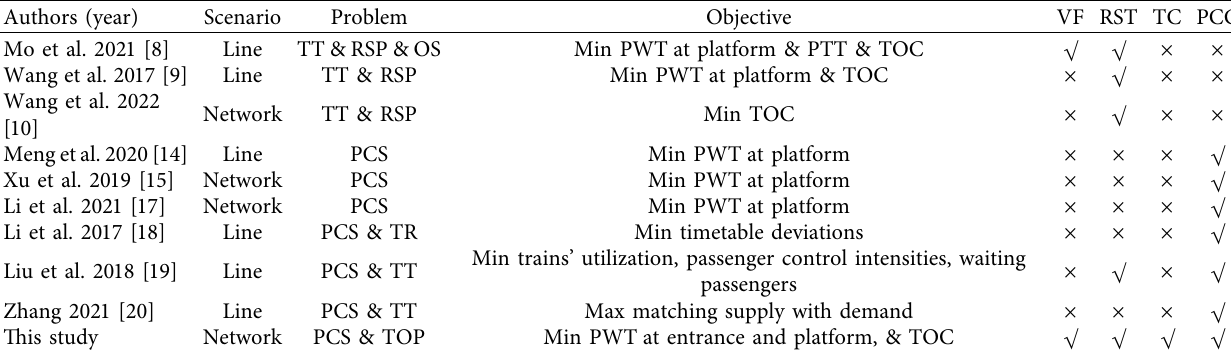
Table 1: An overview of recent related research.